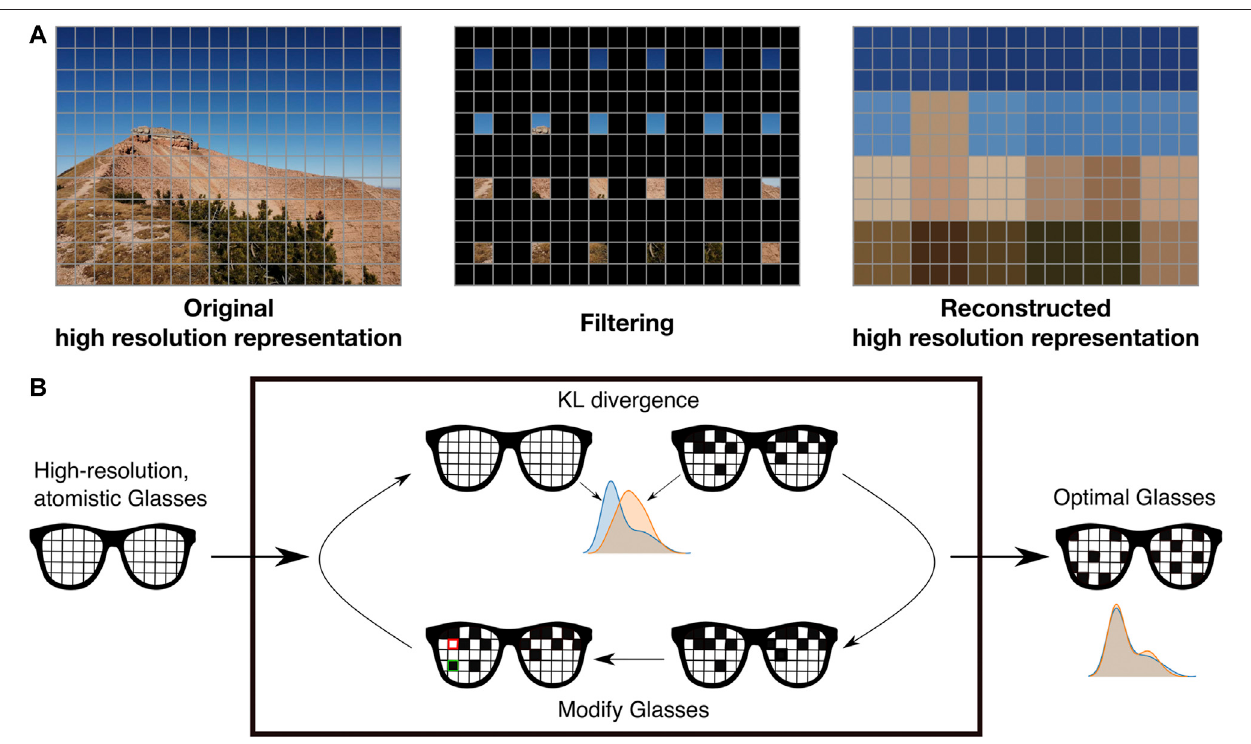
FIGURE 5 | (A) The mapping entropy is de fi ned as the Kullback-Leibler distance between the atomistic, fully detailed probability distribution (left panel) and its blurred reconstruction (right panel) , obtained from a reduced description obtained neglecting a subset of degrees of freedom (middle panel) . (B) The algorithmic implementation of the method introduced by Giulini and coworkers (Giulini et al., 2020) iteratively re fi nes the CG mapping until convergence: the resulting, optimal SLR generates a reconstructed FLR that adheres as much as possible to the original